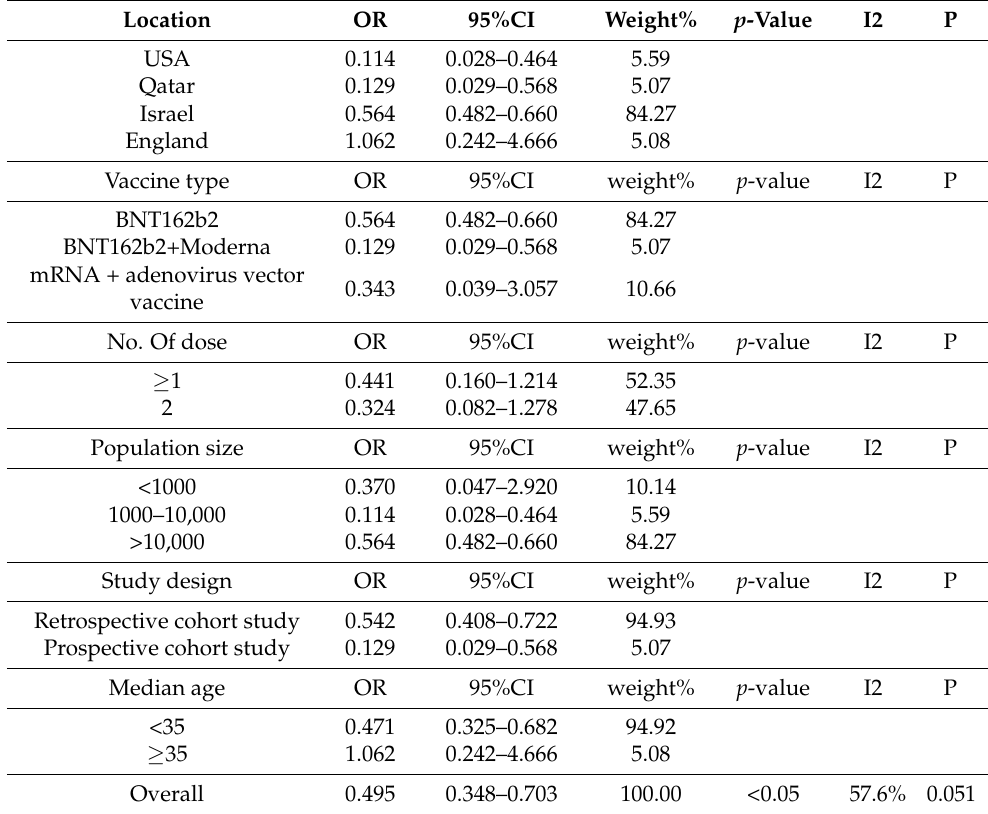
Table 6. Subgroup analysis of incidence of infection after COVID-19 vaccination, by location, vaccine type, number of doses, population size, study design and median age of